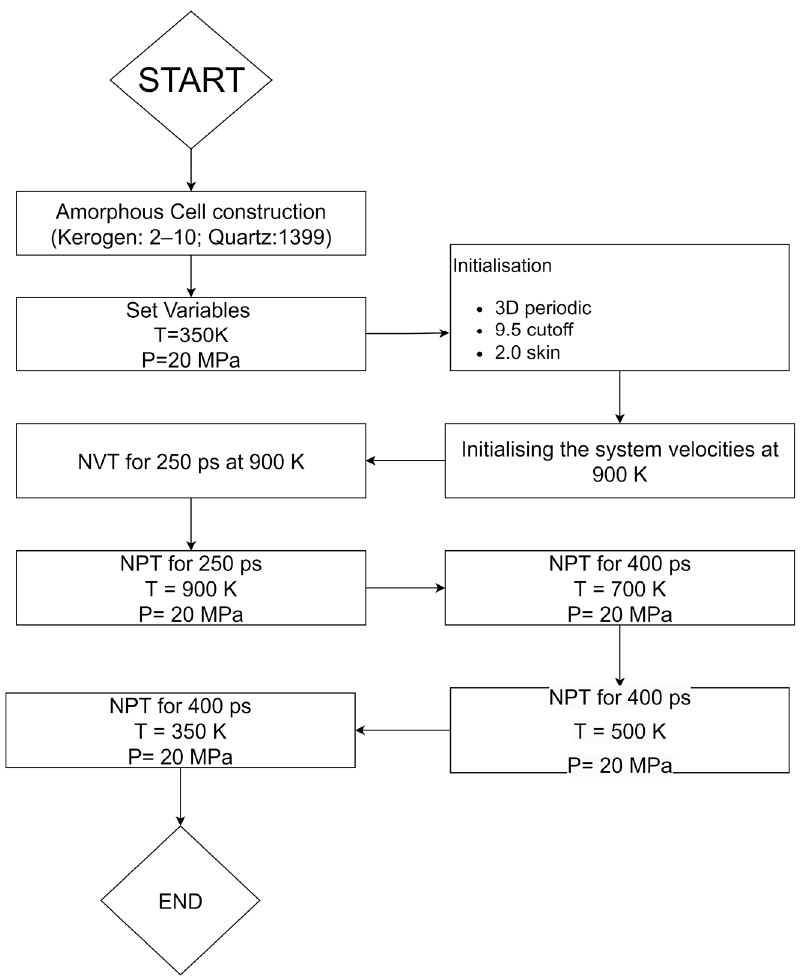
Figure 5. Workflow of the construction of amorphous shale structure.